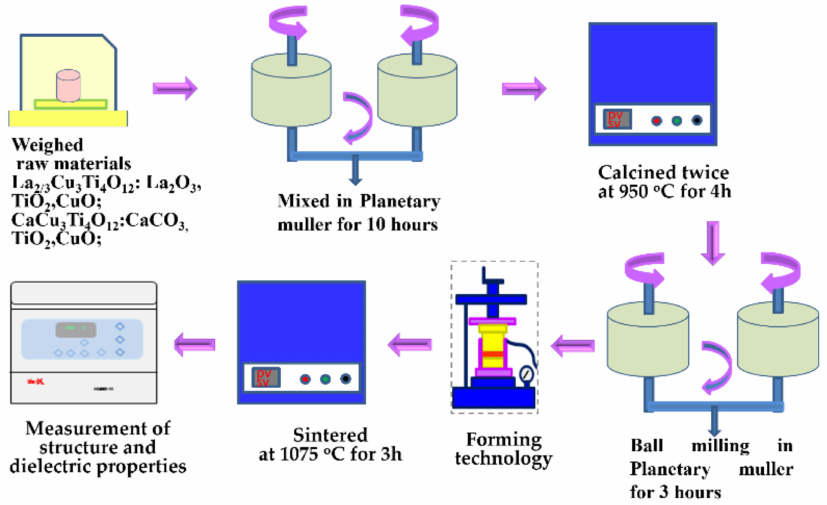
Figure 1. Flow chart of sample preparation.